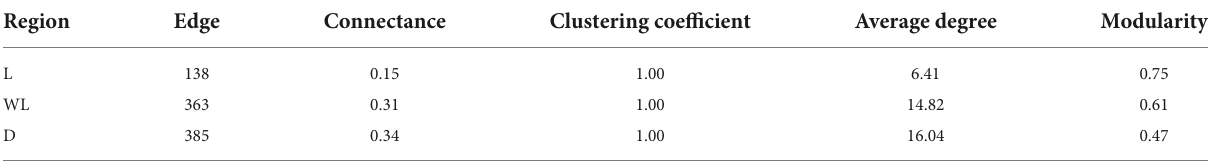
TABLE 2 The co-occurrence network parameter in different light-strength regions. Region Edge Connectance Clustering coefficient Average degree